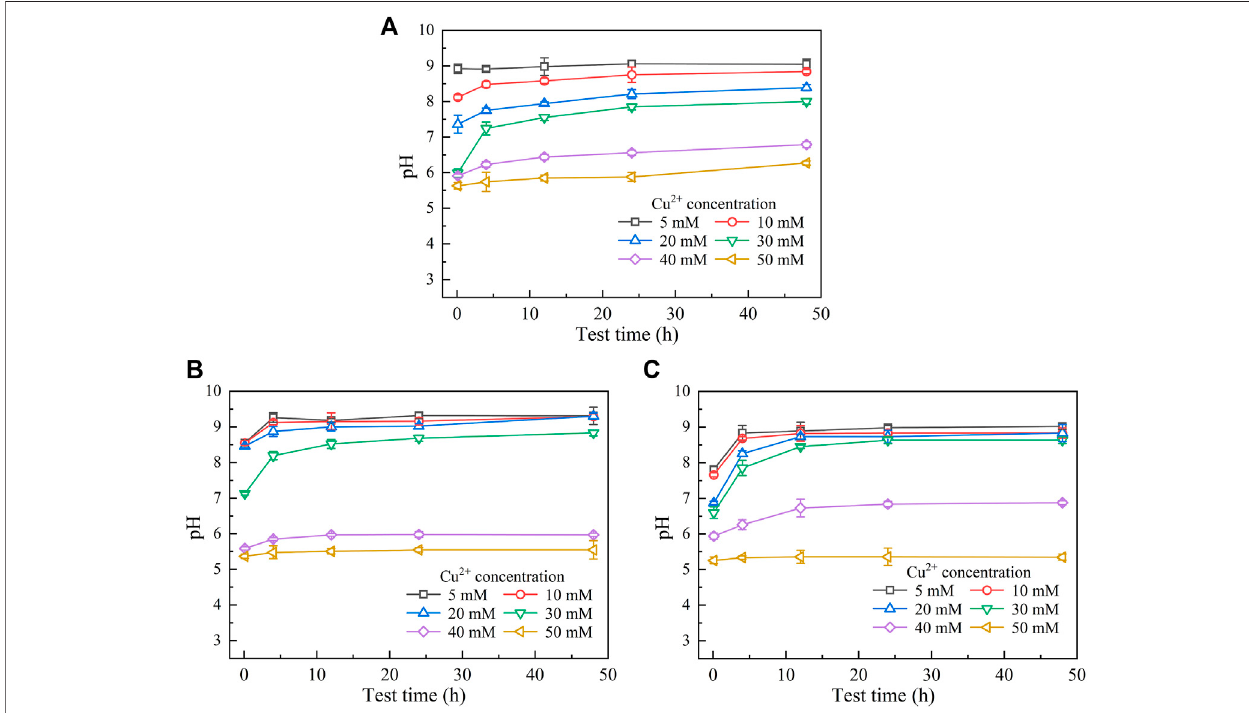
FIGURE4| TemporalrelationshipsofpHagainstCu(NO 3 ) 2 concentrations: (A) withoutyeastextractandCaCl 2 , (B) undertheeffectofyeastextract,and (C) under the effect of yeast extract and CaCl 2 addition.